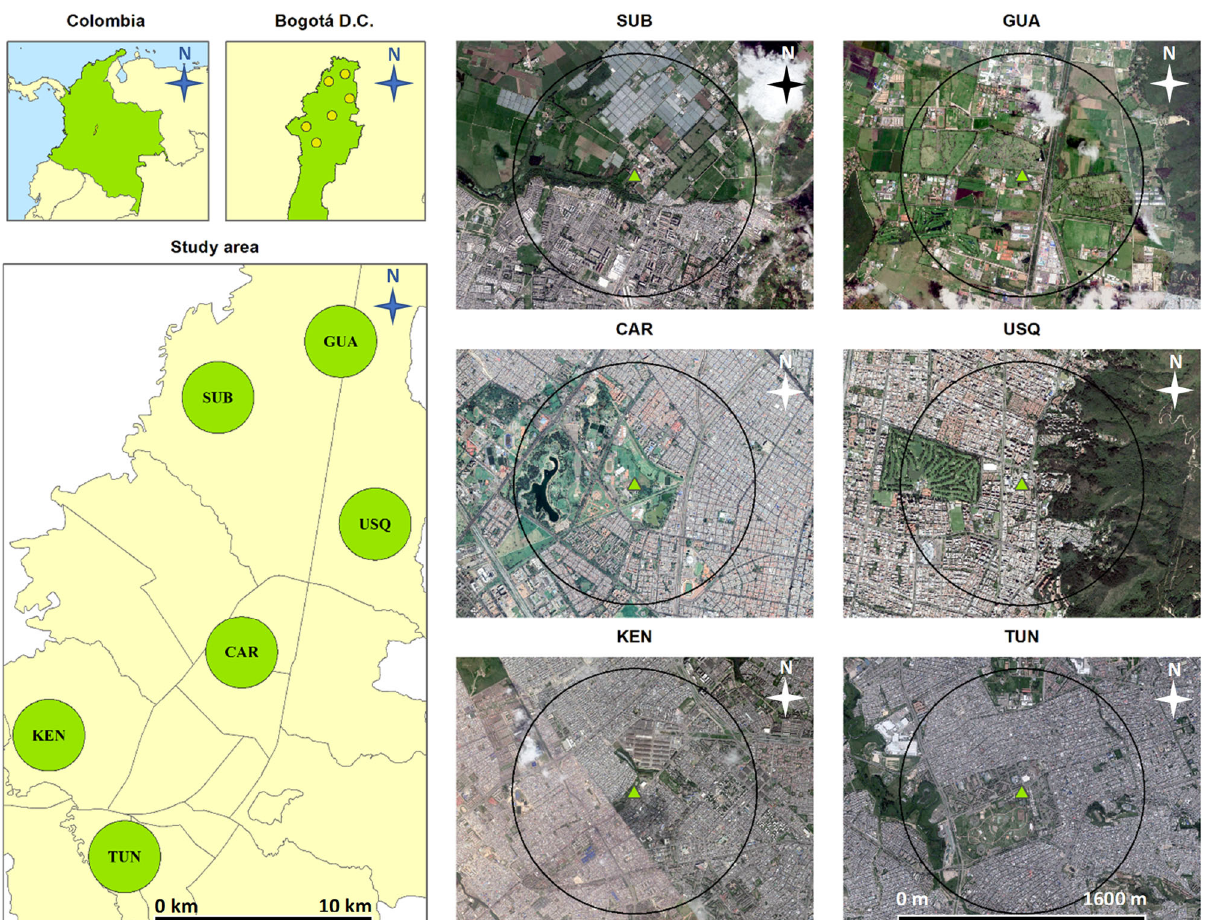
Figure 1. Location of the monitoring stations established in the study megacity (Google Earth Pro, https://earth.google.com/web/search/Bogot%C3%A1, accessed on 28 October 2018).